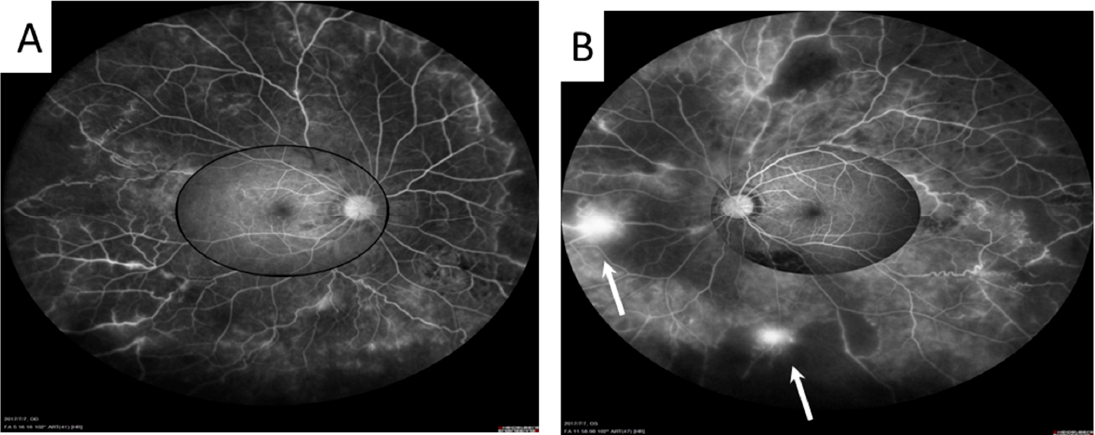
Figure 6. The Heidelberg Spectralis UWFA imaging system (Heidelberg Engineering, Heidelberg, Germany) provides a 105-degree, high-contrast, peripheral retinal image. It showed widespread peripheral vasculitis and capillary nonperfusion in both eyes ( A , B ). Retinal neovascularization ( B , arrow) in the left eye was found, which was not revealed by the previous traditional FA.